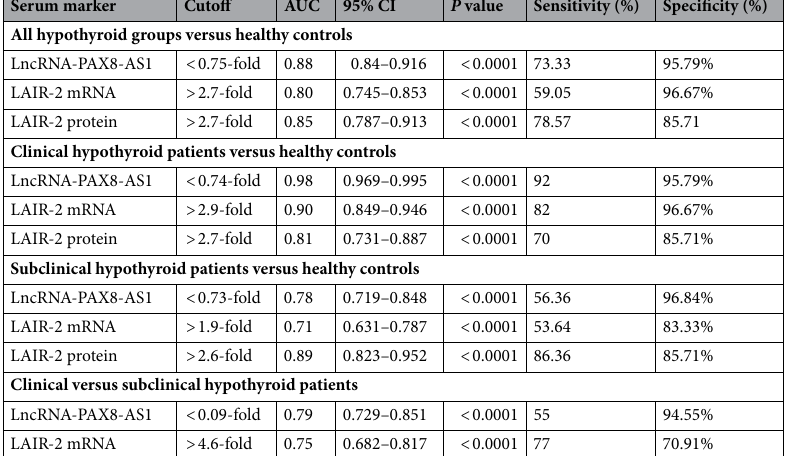
Serum marker Cutoff AUC 95% CI P